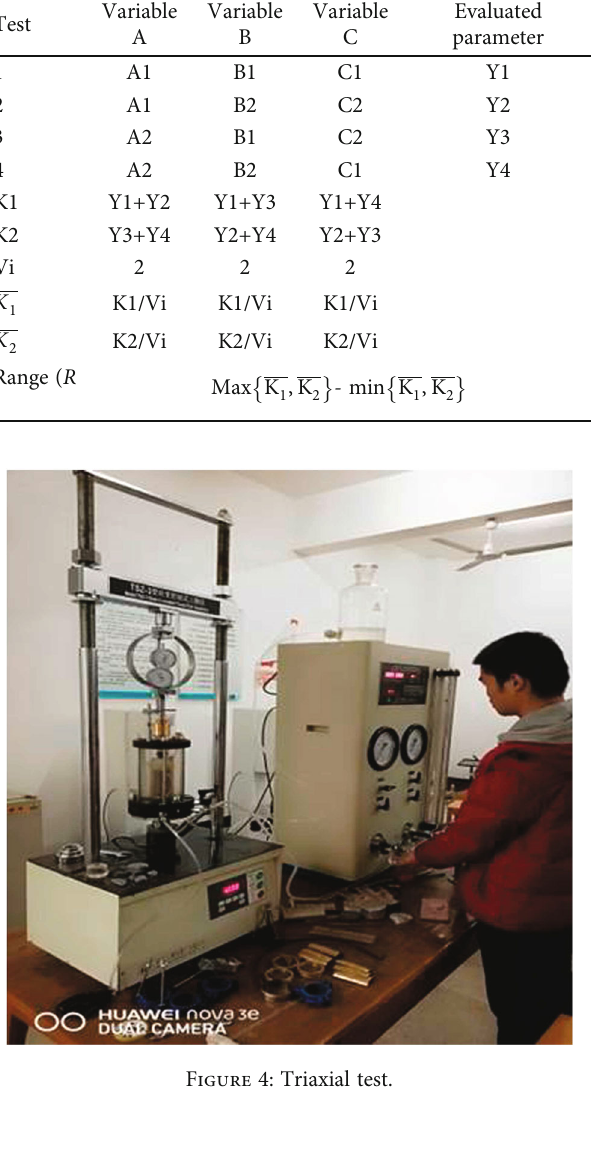
Table 4: Examples of Taguchi ’ s method for range analysis.